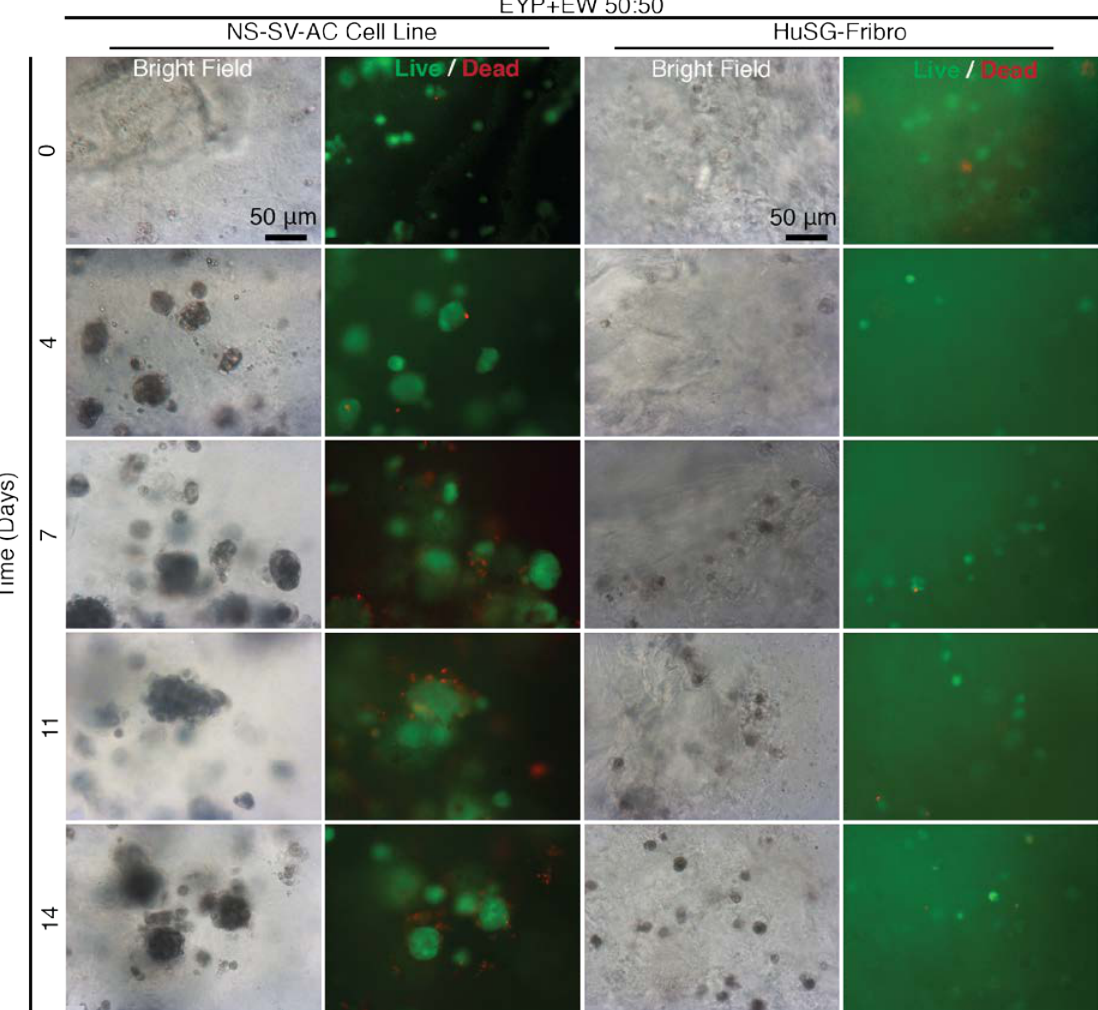
Figure 5. Bright Field and Fluorescent Images of NS-SV-AC and HuSG-Fibro Cells in EYP + EW 50:50 mixtures stained with Live/Dead over 14 days. Images were captured with 20X objective at a random plane of focus in the well. Scale bars are identical in all images. Bright field movies showing progress through the z layers can be found in Videos S1 and S2.